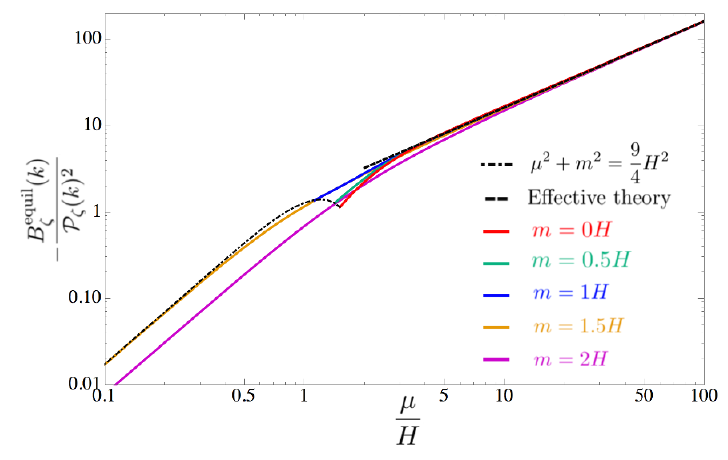
Figure 7 . The scaled equilateral three-point function due to the s@(cid:25)@(cid:25) interaction, B equil ( k ) = P (cid:16) ( k ) 2 as a function of (cid:22)=H . Several values of m are plotted: m = 0, 0 : 5 H , H , (cid:16) 1 : 5 H , and 2 H , and there is also a black dashed line representing the result computed in the large (cid:22)=H e(cid:11)ective theory.